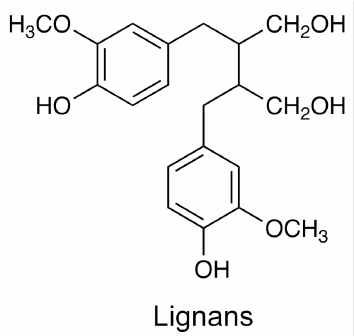
Figure 7. The chemical structure for